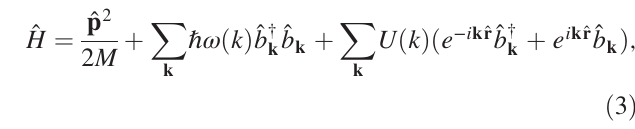
The three sets of experimental data points in Fig. 6 correspond to the three different fixed IX H densities extracted from the datasets in Fig. 5 for the three different applied electric fields (the associated estimated probing IX H densities are listed in the figure caption).